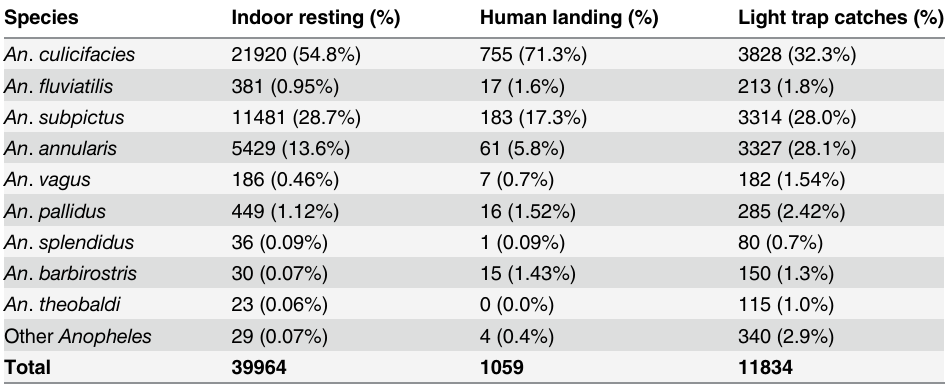
Table 1. Number and proportion of anophelines caught by different methods in study villages of dis- trict Jabalpur. Species Indoor resting (%) Human landing